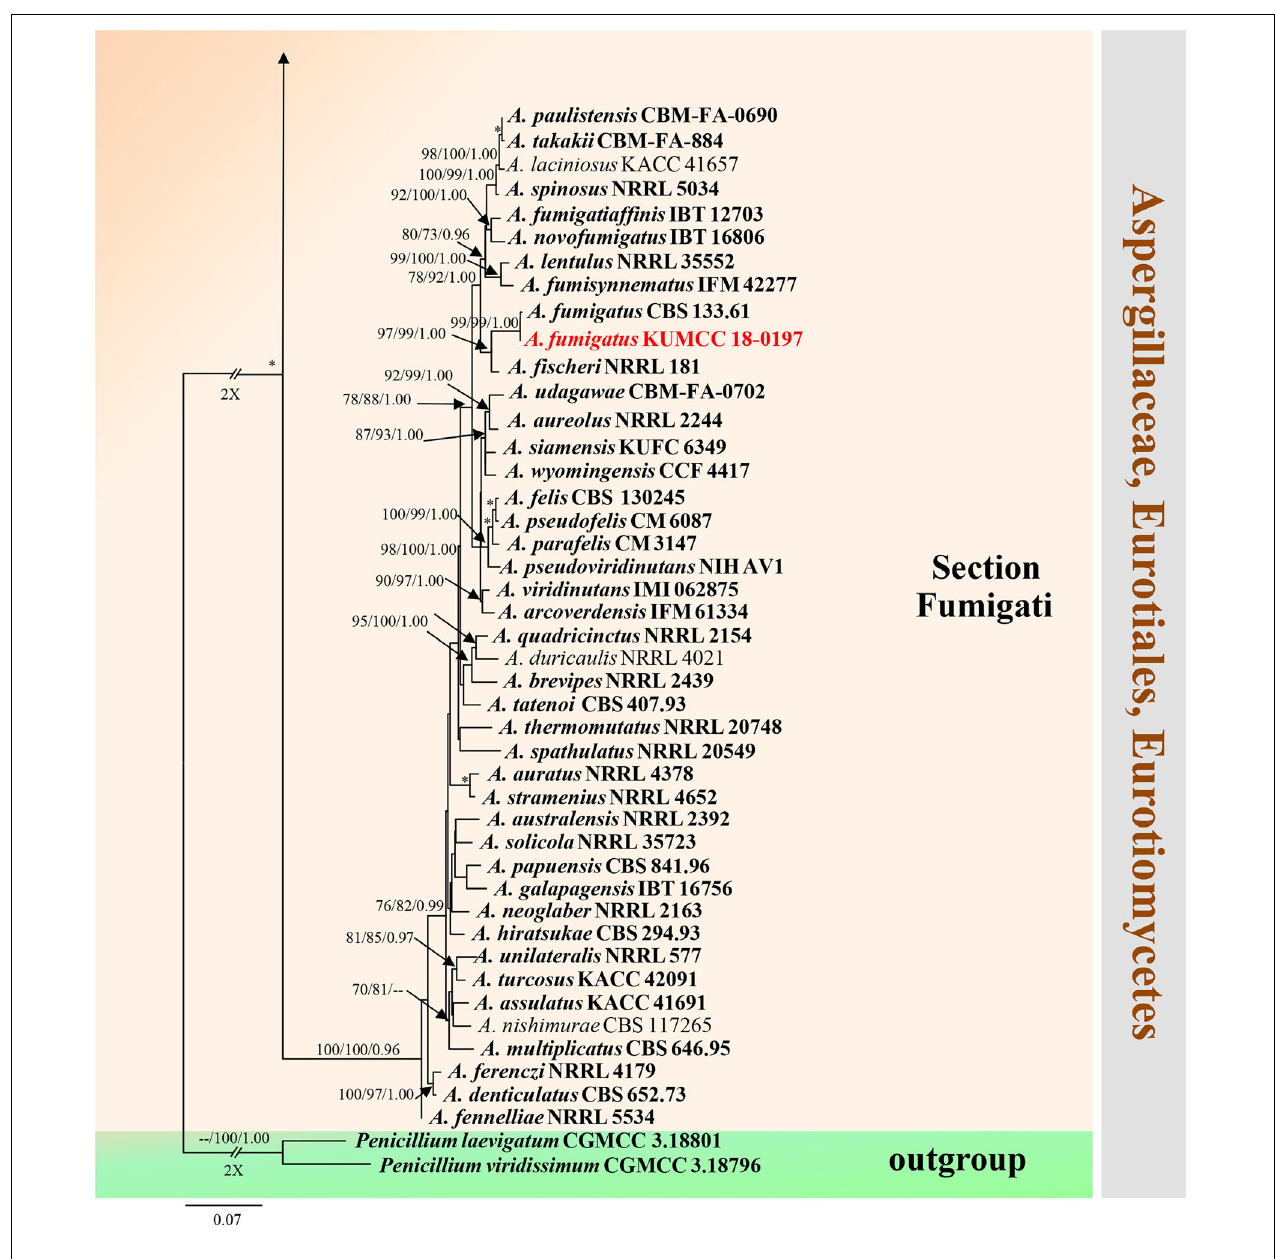
FIGURE 6 | Phylogram generated from maximum likelihood analysis based on combined CaM , BenA , ITS and RPB2 sequence data. One hundred and three sequences are included in the combined analysis, which consisted of 2805 characters including alignment gaps. The tree is rooted to Penicillium viridissimum (CGMCC 3.18796) and P. laevigatum (CGMCC 3.18801). The MP analysis for the combined dataset had 1199 parsimony informative, 1432 constant, 174 parsimony uninformative and yielded 356 most parsimonious trees. The best-fit model HKY + I + G was selected for CaM , BenA , GTR + I + G for ITS and RPB2 in BI analysis. Maximum parsimony and maximum likelihood bootstrap values ≥ 70% and Bayesian posterior probabilities ≥ 0.90 (MPBS/MLBS/BYPP) are indicated at the nodes. Branches with 100% MPBS, 100% MLBS and 1.00 BYPP values are indicated as an asterisk ( ∗ ). The ex-type strains are bolded black, and the new isolates are in